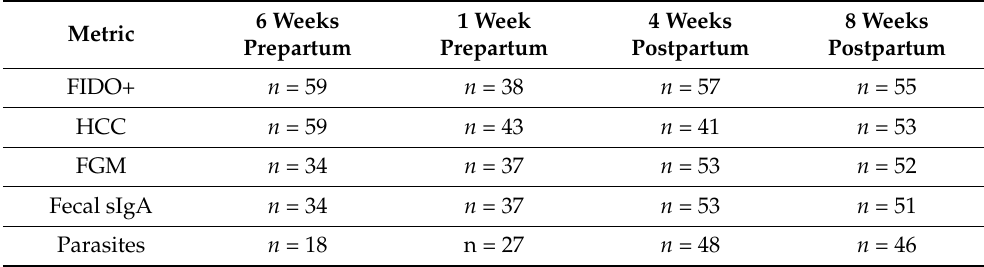
Table 2. Sample Sizes for each variable and time